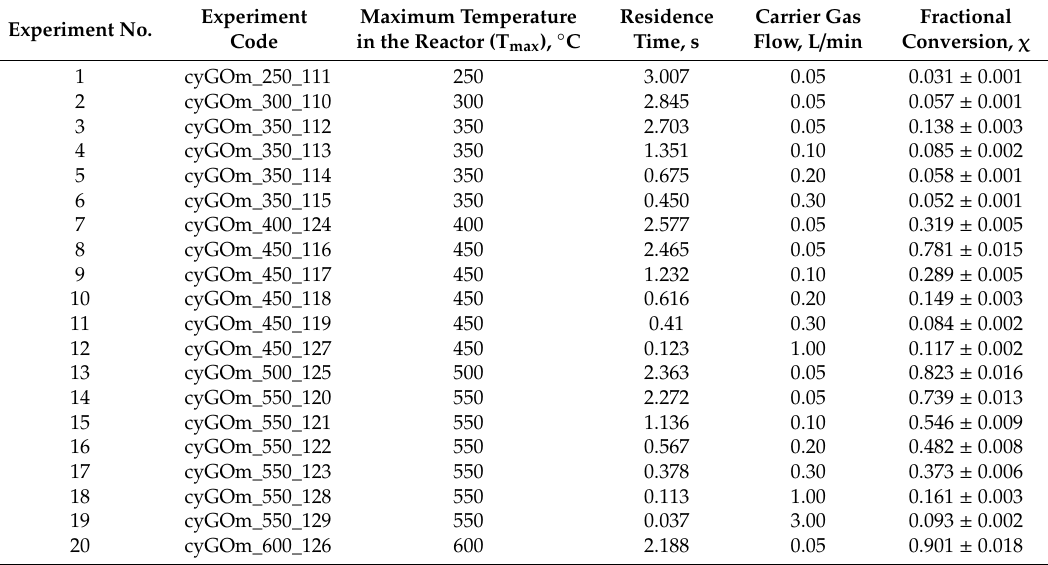
Table 5. Results of the kinetic measurements of O-methyl-N-(n-butyl) carbamate thermolysis (1a). Experiment